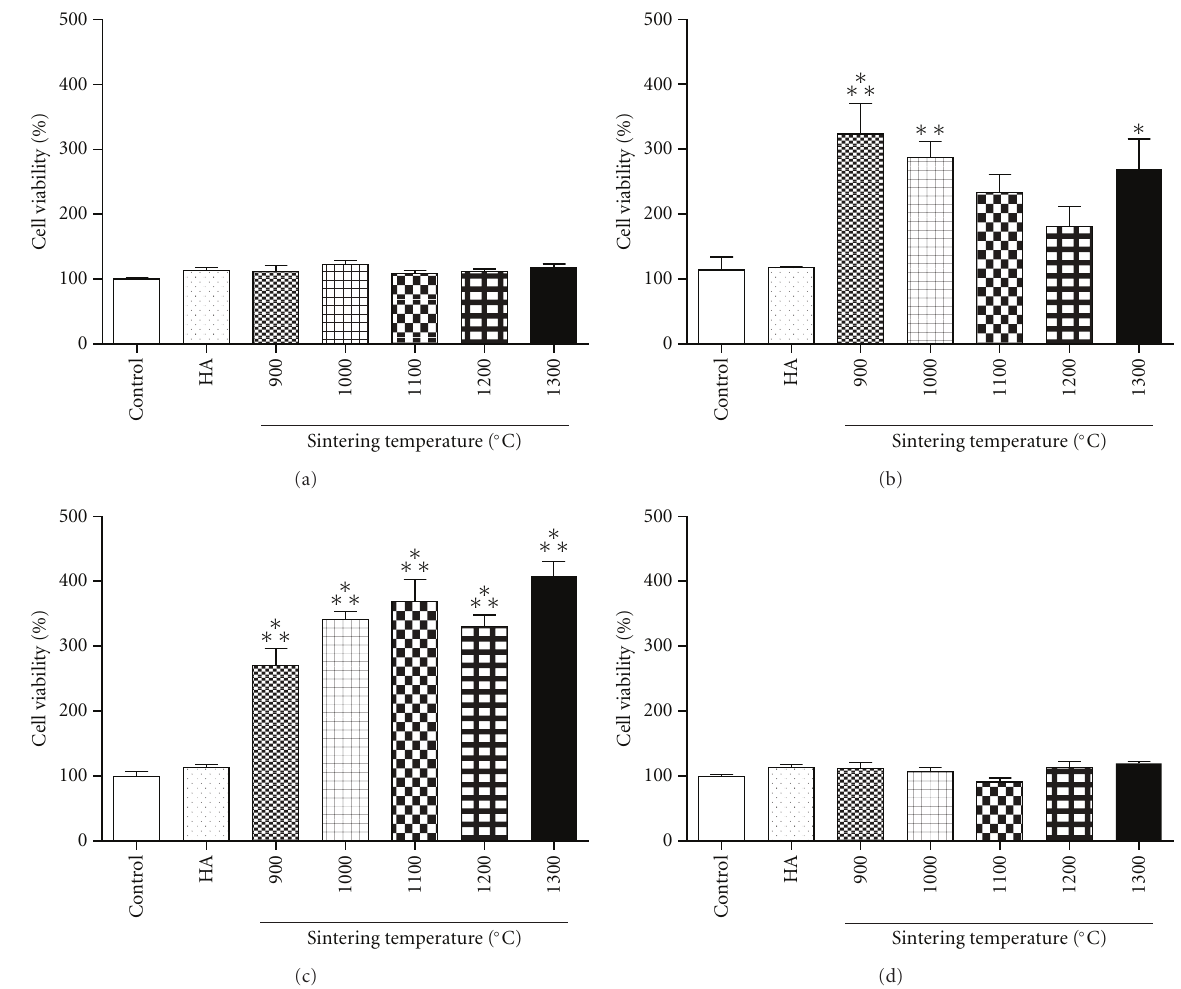
Figure 1: Cellular viability of osteoblasts cultured in the presence of di ff erent concentrations of LiHA. (a) 0.25% LiHA, (b) 0.50% LiHA, (c) 1.0% LiHA, and (d) 2.0% LiHA. The results are expressed as the means ± SD, ( ∗ ) indicating a significant di ff erence comparing to control with P < 0 .